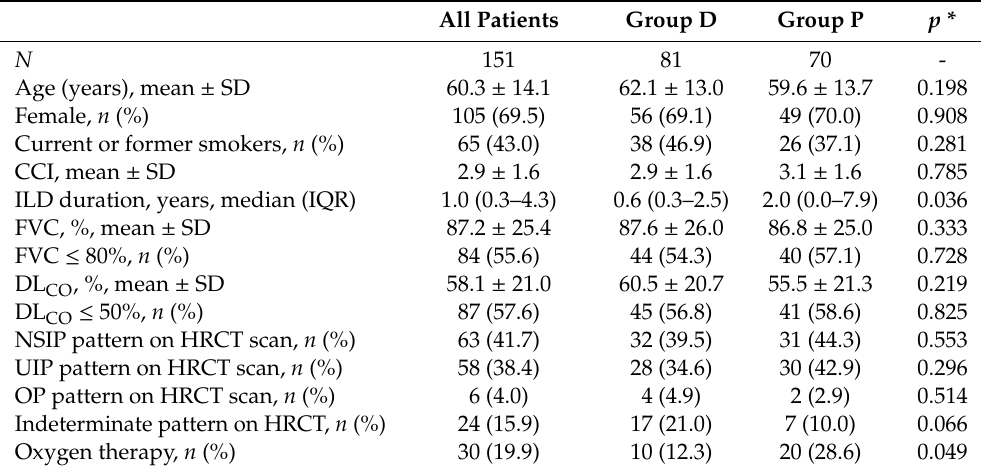
Table 1. Characteristics of patients discussed at